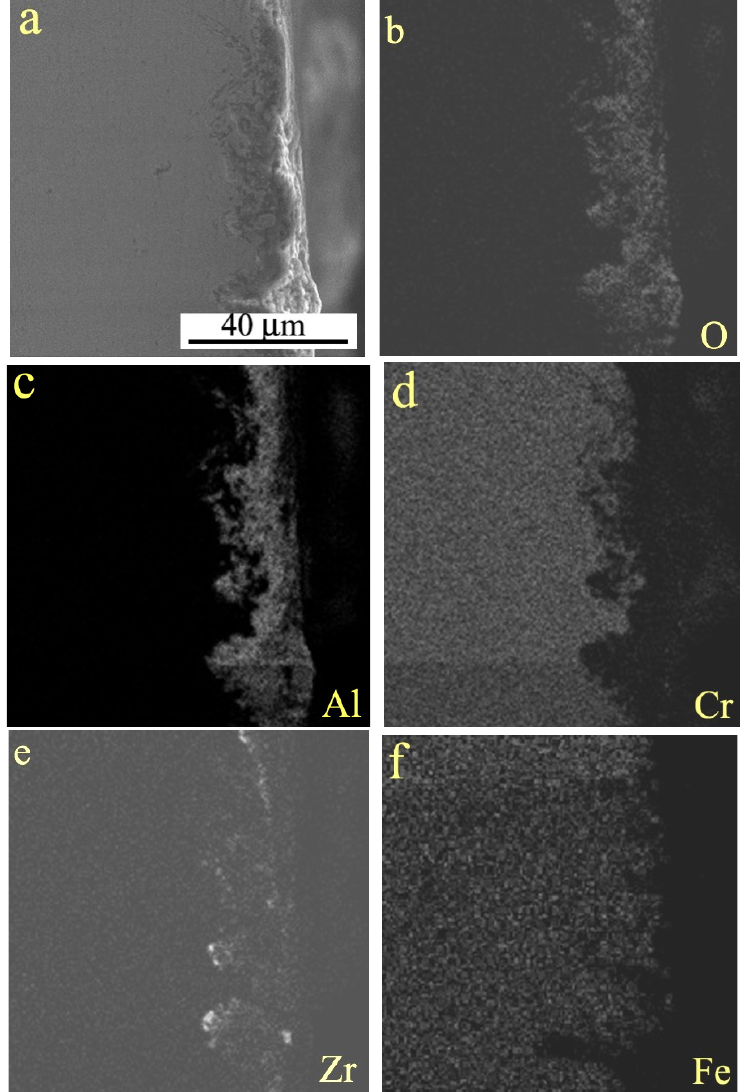
Figure 7. SEM image and elemental mappings of cross-sectional microstructure of sample oxidized at 1280 °C for 3 h: ( a ) SEM image, ( b ) O, ( c ) Al, ( d ) Cr, ( e ) Zr, ( f ) Fe.